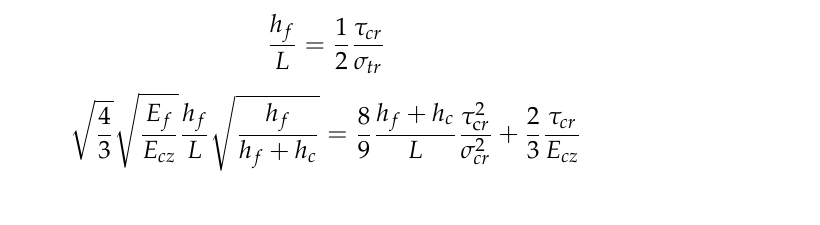
Figure 10. The effect of span distance on failure load under three-point bending: ( a ) Sandwich beam with 3.175 mm MDF face and 15.875 mm core; ( b ) sandwich beam with 3.175 mm MDF face and 25.4 mm core; ( c ) sandwich beam with 3.175 mm MDF face and 34.925 mm core.